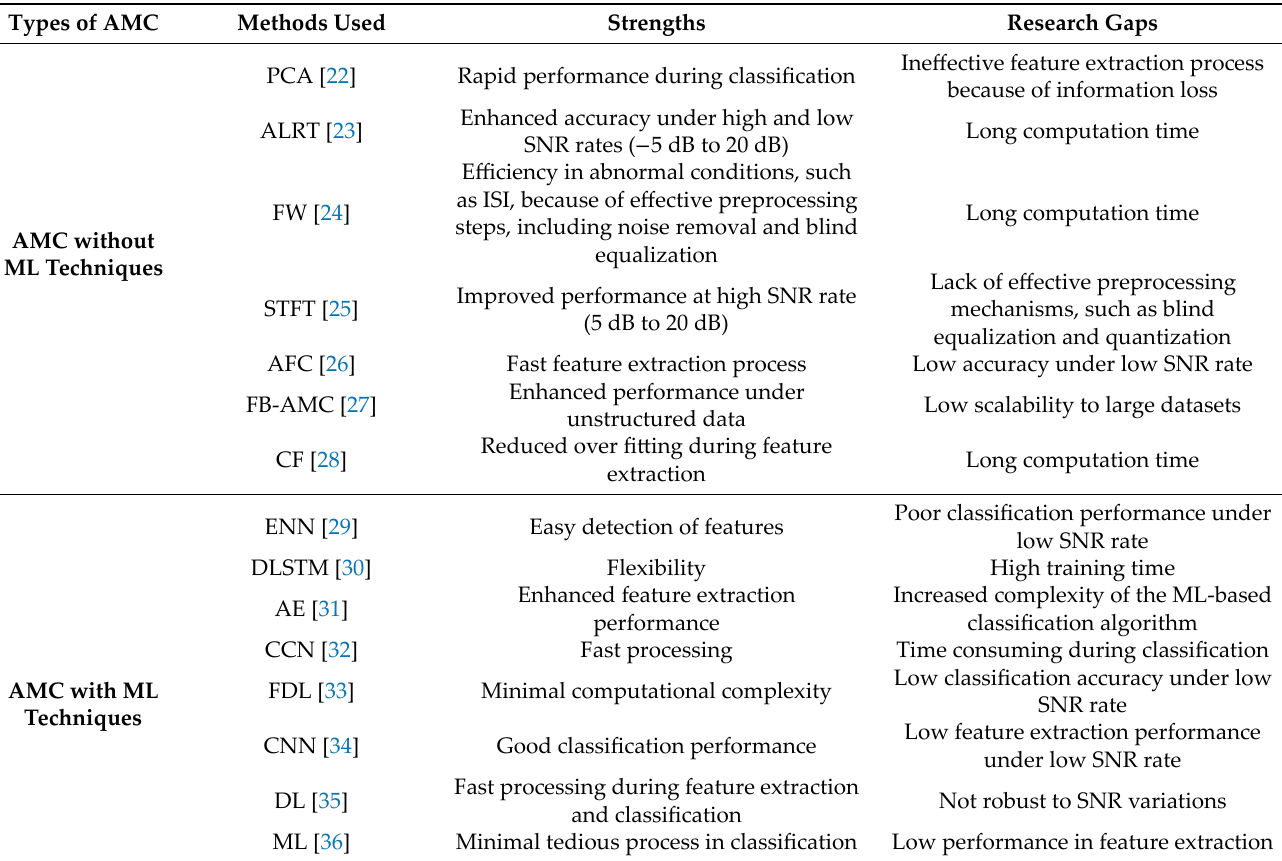
Table 1. Research strength and gaps of